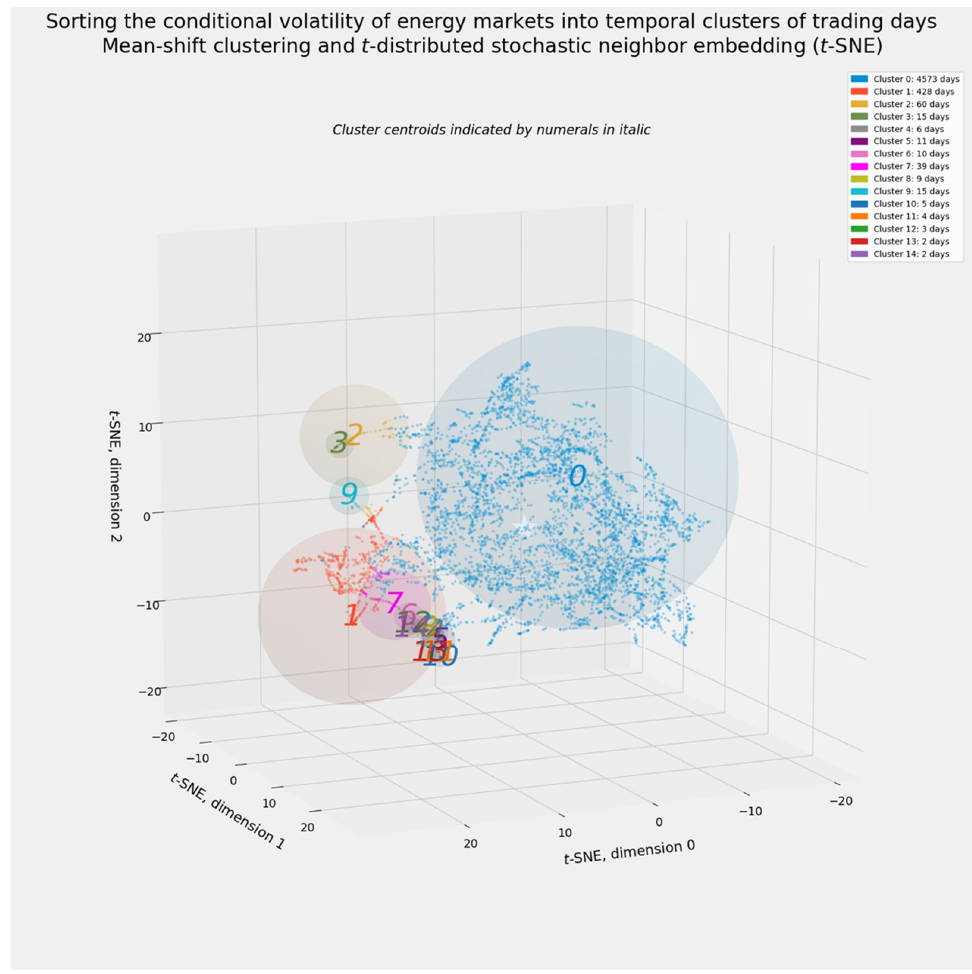
Figure 20. Mean-shift clustering of energy-related markets—A t -SNE manifold.